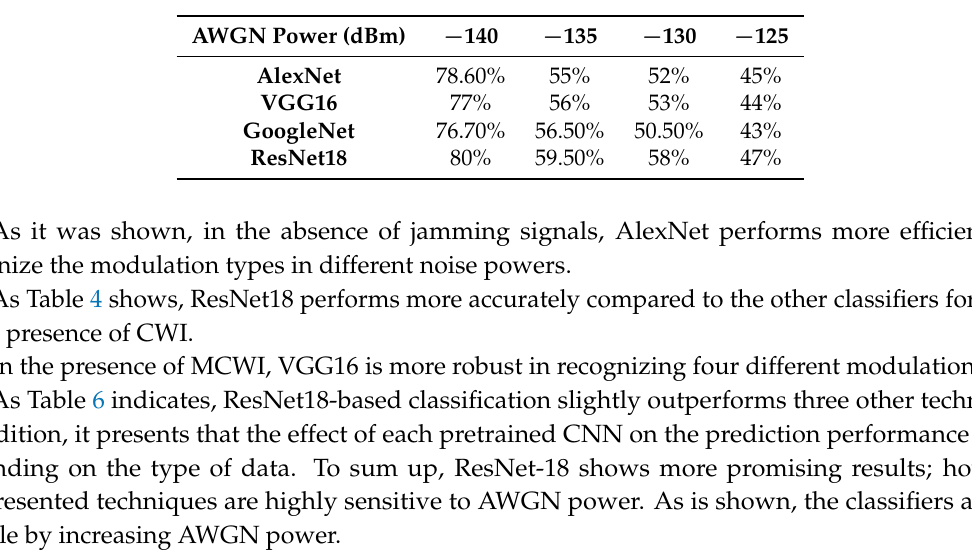
Table 6. The prediction result for